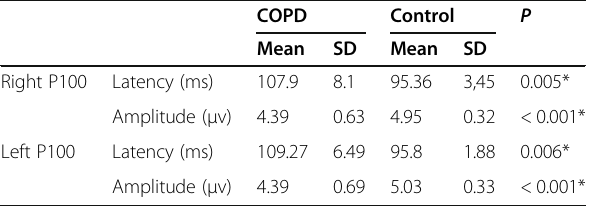
Table 4 Comparison between patient and control groups as regards the visual evoked potential